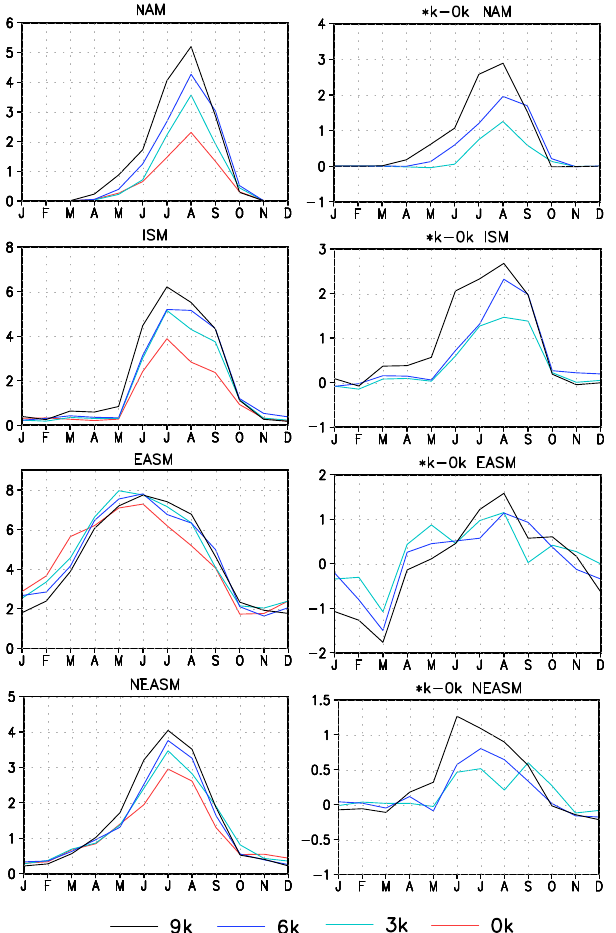
Figure 11. Simulated seasonal precipitation cycle (mmday − 1 ) for different time-slices (9, 6, 3,and 0k) and the different monsoon sub- regions in the Afro-Asian monsoon domain, as well as the change in seasonal precipitation cycle (mmday − 1 ) between 9/6/3 and 0k, based on the transient Holocene simulation performed in KCM. The regions are: the North African monsoon region (NAM), Indian mon- soon region (ISM), East Asian monsoon region (EASM), and the northern part of the East Asian monsoon region (NEASM). Please note the change in scale.